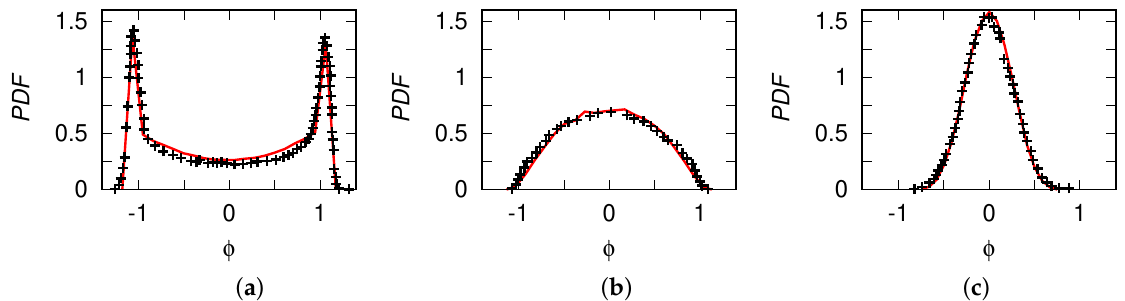
Figure 4. Scalar PDF evolution: results of bounded Langevin model (red lines) taken at time instants (cid:112) (cid:104) (cid:112) (cid:104) (cid:112) (cid:104) φ 2 (cid:105) / (cid:104) φ 2 (cid:105) 0 = 0.92, ( b ) φ 2 (cid:105) / (cid:104) φ 2 (cid:105) 0 = 0.54, ( c ) φ 2 (cid:105) / (cid:104) φ 2 (cid:105) 0 = 0.28. Symbols ( + ): corresponding to: ( a ) DNS reference data of Eswaran and Pope